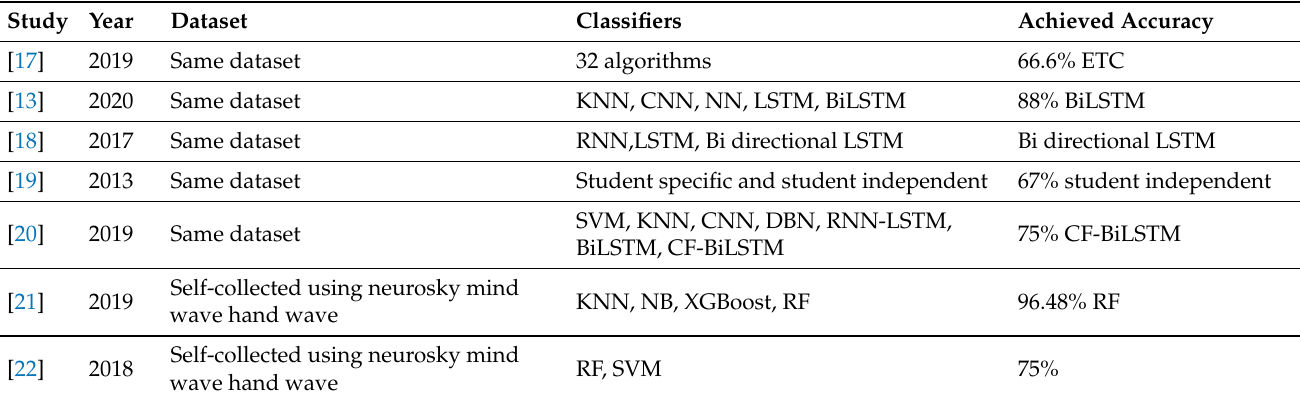
Table 1. Summary of the systematic analysis studies in related